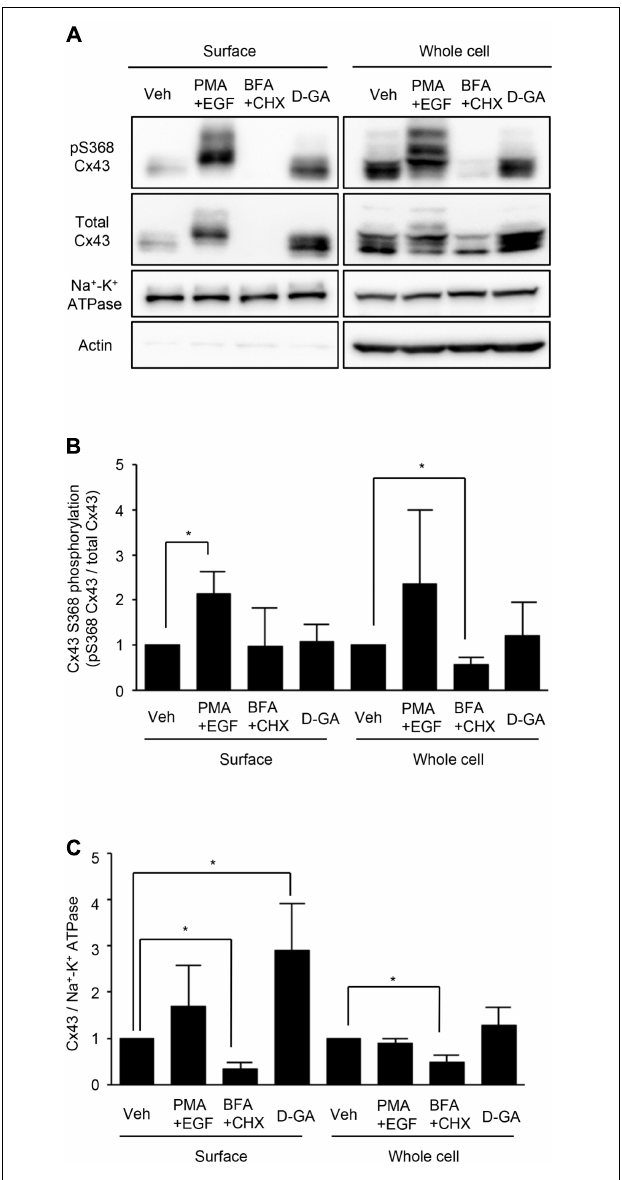
FIGURE 5 | Effect of D-GA treatment on surface expression and S368 phosphorylation of Cx43. LN215-Cx43 cells were grown to 80% confluency in 100 mm plates before treatment with vehicle, 100 ng/mL PMA combined with 50 ng/mL EGF, 1 µ g/mL BFA combined with 10 µ g/mL CHX or 20 µ M D-GA. The treatments were conducted for 10 min except for BFA + CHX, which was treated for 6 h. The whole cell lysates were prepared after surface biotinylation. Biotinylated proteins from 500 µ g protein of the whole cell lysates and 20 µ g protein of the whole cell lysates were used for immunoblotting of anti-phospho-S368 and total Cx43, anti-Na + –K + ATPase, and anti-actin antibodies. Three independent experiments were conducted, and representative blots are presented in (A) . The images before cropping are also presented in Supplementary Figures 1A–E. The relative phospho-S368 Cx43 band intensity, divided by the total Cx43 band intensity, is reflective of Cx43 S368-phosphorylation and was calculated and presented as bar graphs (B) . The data represent the mean ± SD ( n = 3). The band intensity of total Cx43 bands was normalized to Na + –K + ATPase and presented as a bar graph (C) . The data represent the mean ± SD ( n = 3). ∗ P < 0.05 (Student’s t -test); Veh, vehicle.